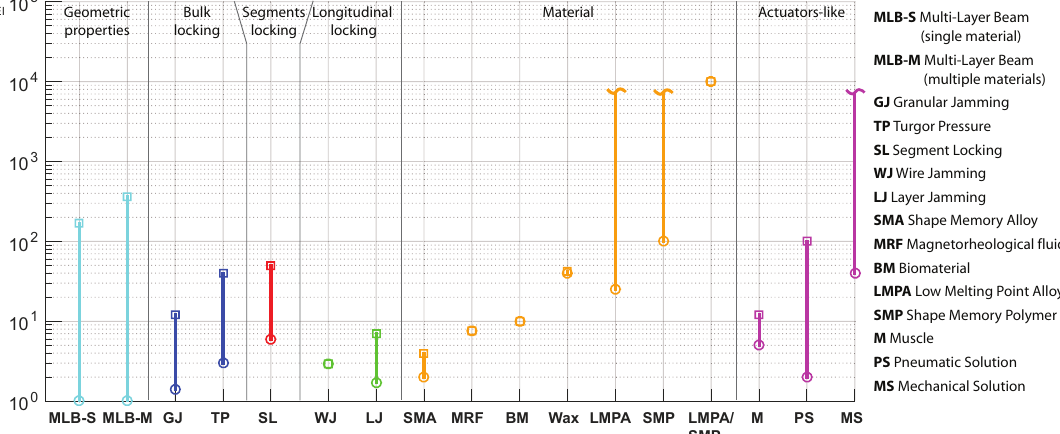
Figure 6. Comparison of the stiffness gain η EI for various solutions presented in the literature presented following the classification introduced in this work. Some solutions (“LMPA”, “SMP” and “MS”) have no upper bound as the literature gives only the lowest stiffness gain they can achieve. The biomaterial value corresponds to the skin of